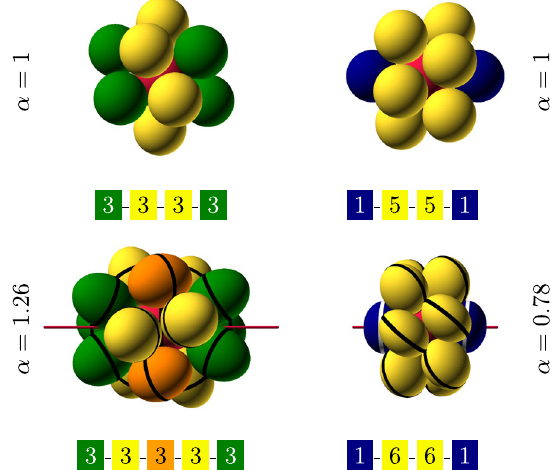
FIG. 1. Densest local structures of ellipsoids. Top row: The 12-neighbor icosahedral cluster of spheres, colored to preserve a threefold rotational axis and three twofolds (left picture), and colored to preserve a fivefold axis plus five twofolds (right picture). Bottom row: Prolate 15-neighbor and oblate 14-neighbor structures generalizing the above. Black or white belts mark the equators of the particles. The red line is the central particle ’ s distinguished axis. Particles of the same color are related by symmetry operations. Boxes label the number of particles in the respective